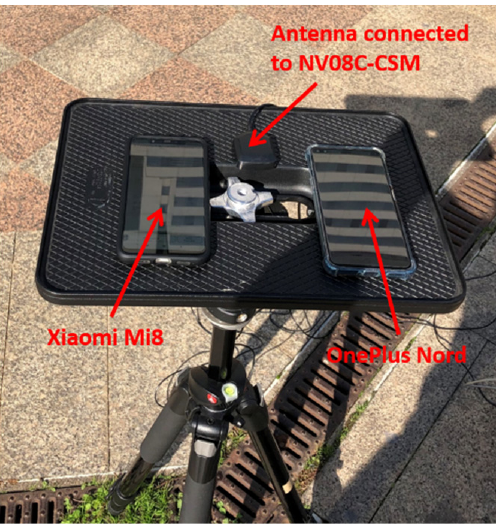
Figure 3. Devices used in the experiment.